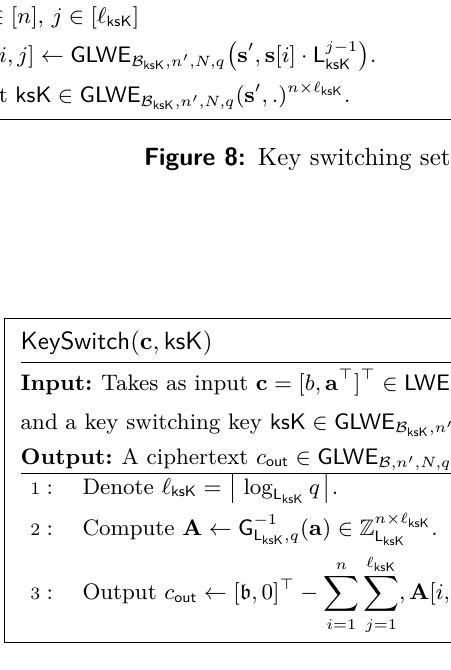
Figure 9: Key switching algorithm and its